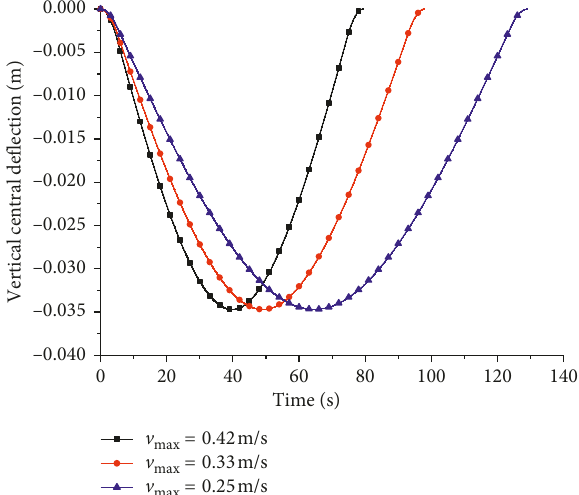
Figure 5: The effect of trolley acceleration on the center deflection of the crane